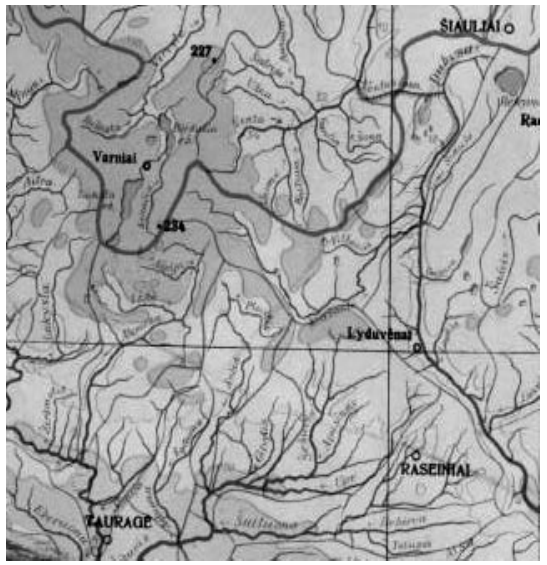
Fig 4. Map of Lithuania, 1:400 000, 1933 hipsometrijai, tai tradiciškai žaliai vaizduojami miškai